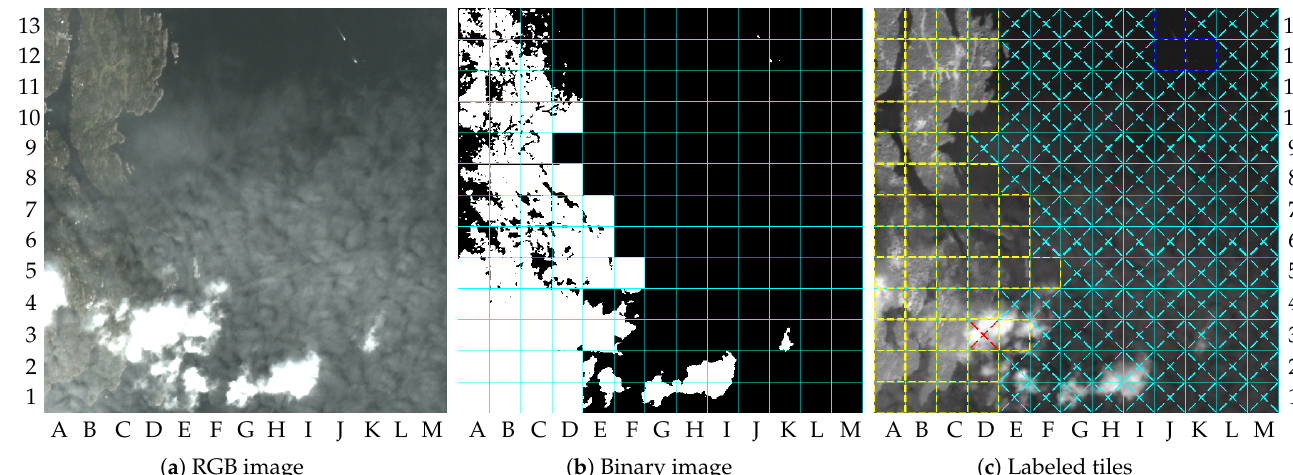
Figure 16. Results for image 20: ( a ) RGB image (truncated at 2000); ( b ) binary image; ( c ) labeled tiles (truncated at